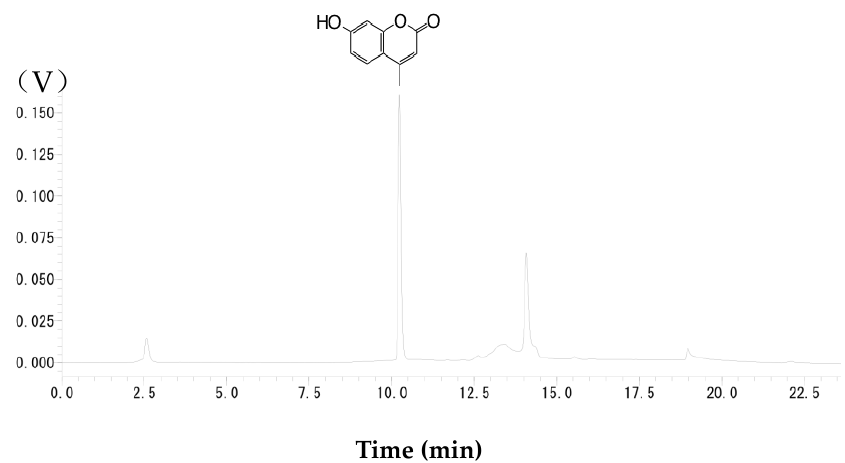
Figure 5. Fluorescence HPLC profile of hydrolysate after lipase reaction. Molecules 2019 , 24 , x FOR PEER REVIEW